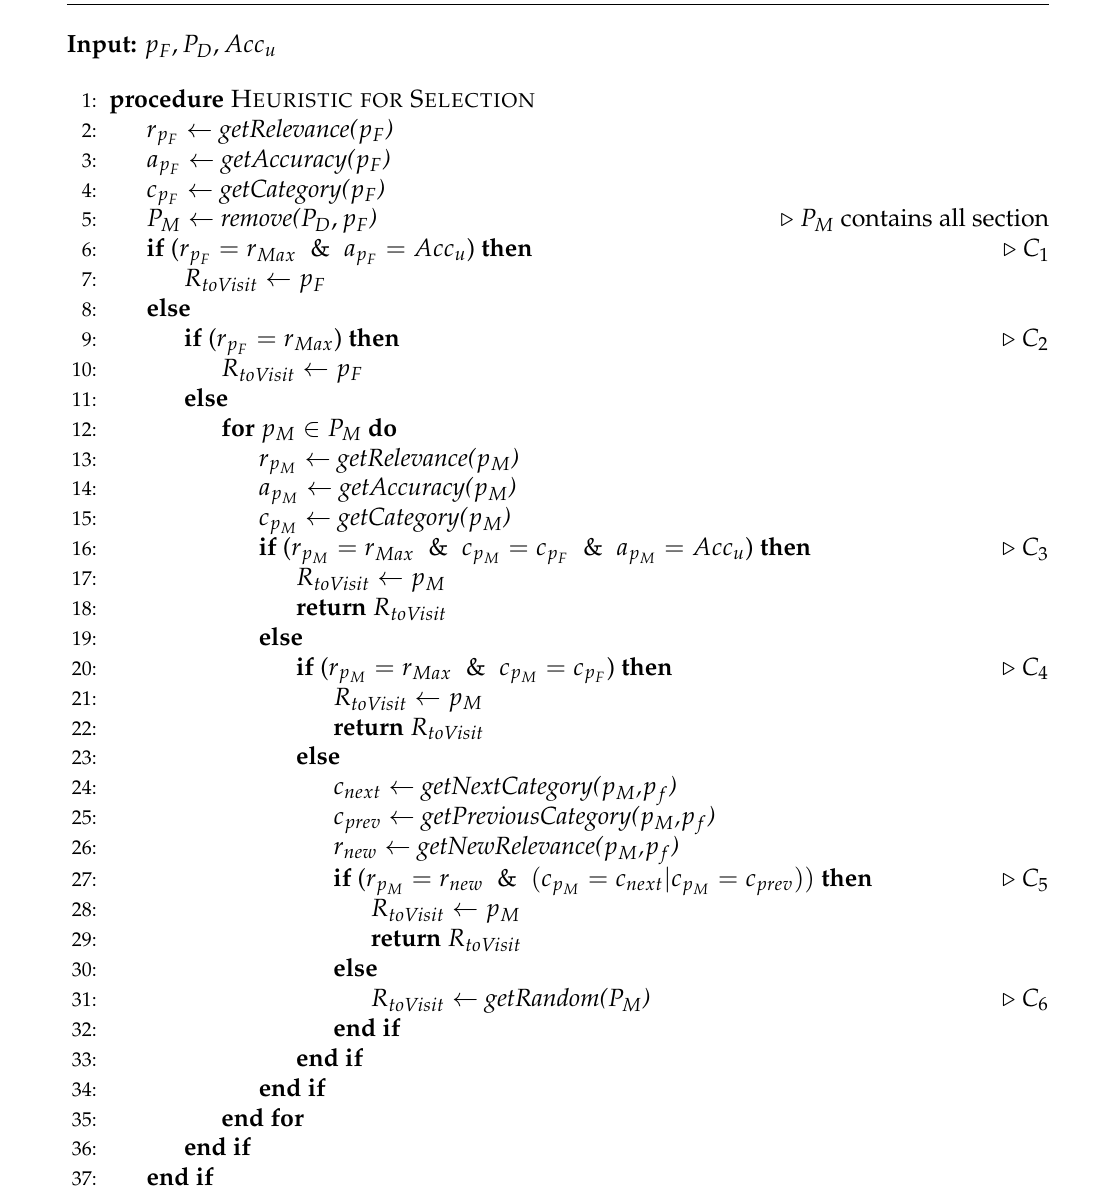
Algorithm A1 Artistic Period Selection